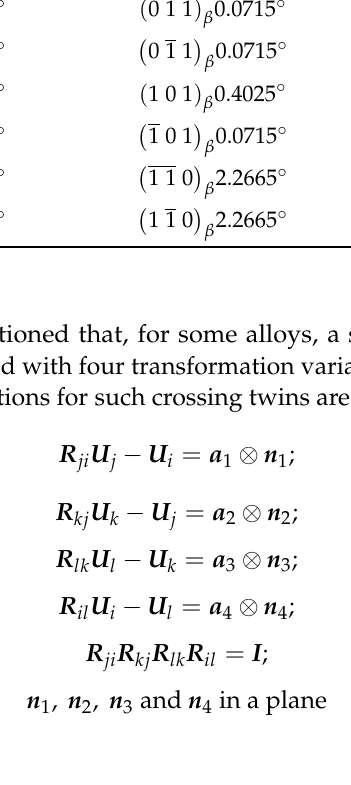
Table 6. Predicted orientation relationships of different variants based on PTMT.